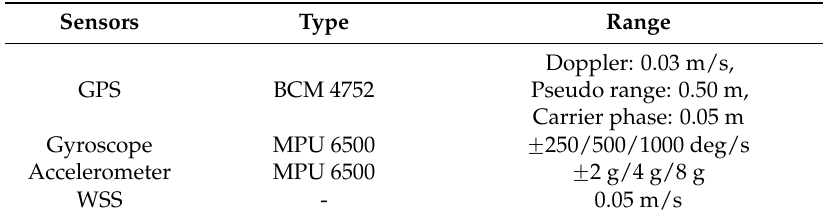
Table 1. Measurement Accuracy of sensors.